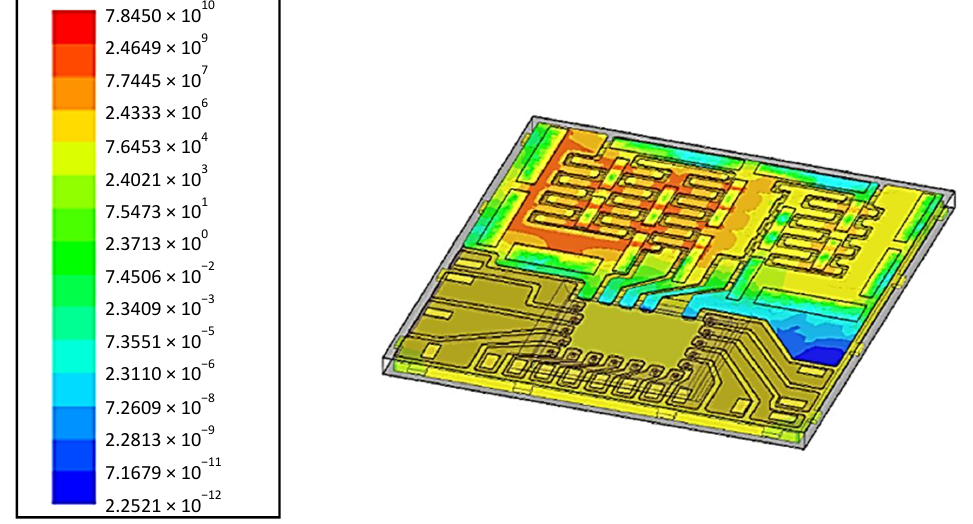
Figure 7. Volume loss density, with a current equal to 90 A at 500 kHz as input.